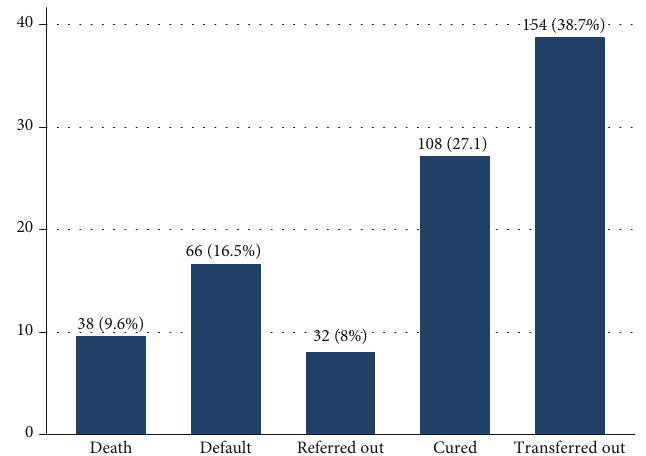
Figure 2: Treatment outcomes of 6 – 59-month-old children admitted for severe acute malnutrition in the therapeutic feeding center at Pawi General Hospital, northwest Ethiopia, from 2013 to 2017 ( n = 398 ).